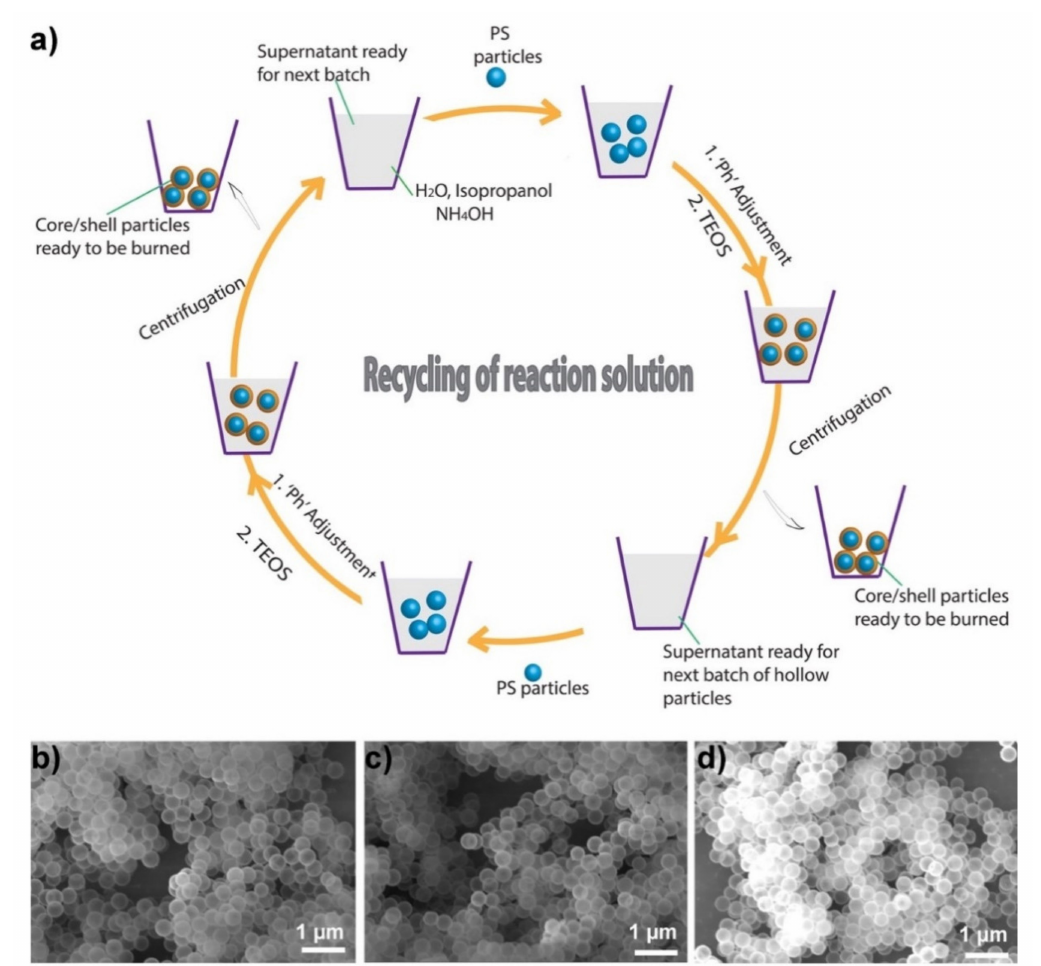
Figure 3. Recycling of the reaction solution. ( a ) Schematic showing the recycling steps. SEM images of the particles synthesized by ( b ) the original reaction mixture, ( c ) the first reiteration, and ( d ) the second reiteration. Note: The process was repeated only three times in this work, but the retrieved solution can be used for several more reiterations as long as the pH is